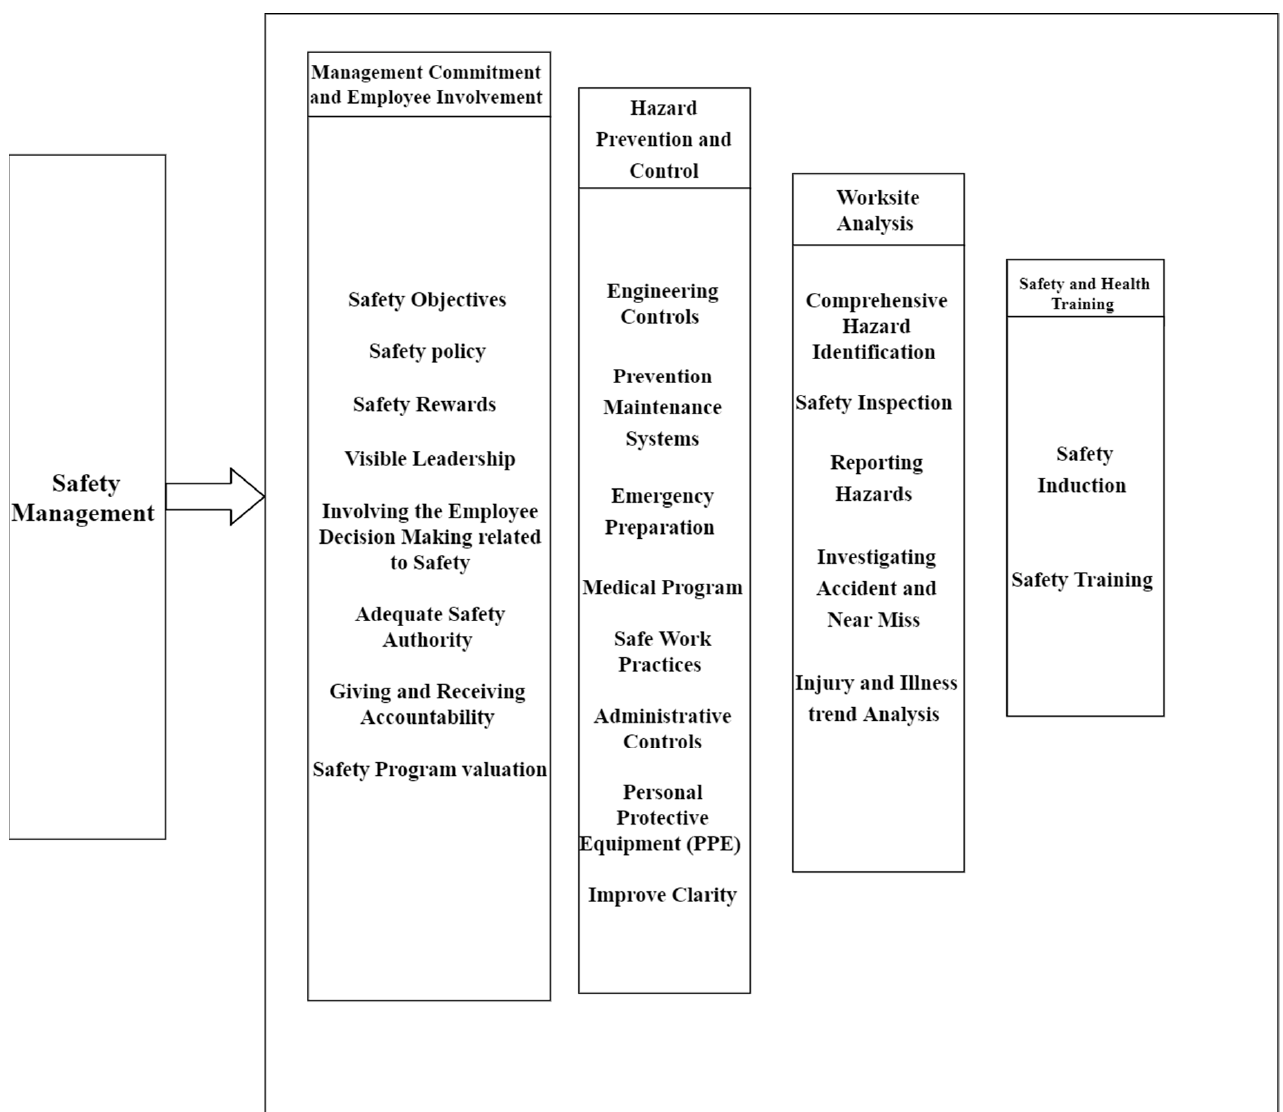
Figure 3. Safety program implementation elements.